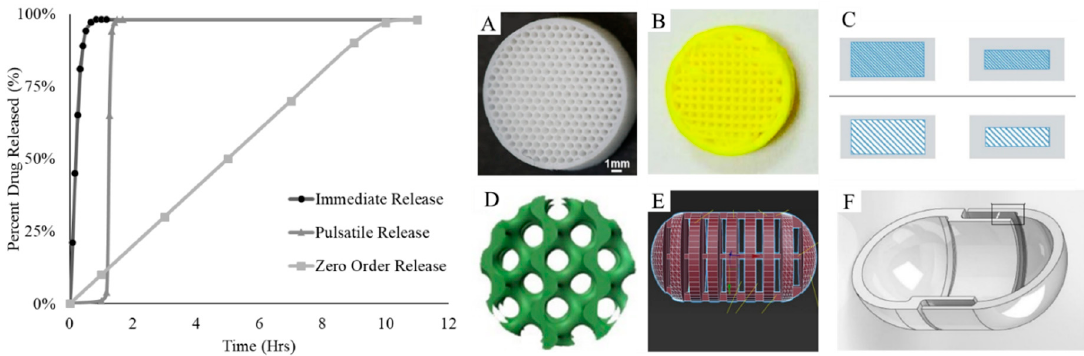
Figure 3. Idealized release profiles (left) and micro-geometry incorporation in oral dosages produced by additive manufacturing techniques ( A – F ). Immediate release is desirable for quick action drugs, such as pain relievers. Immediate release profiles are correlated to infill percentage ( A ) [91],